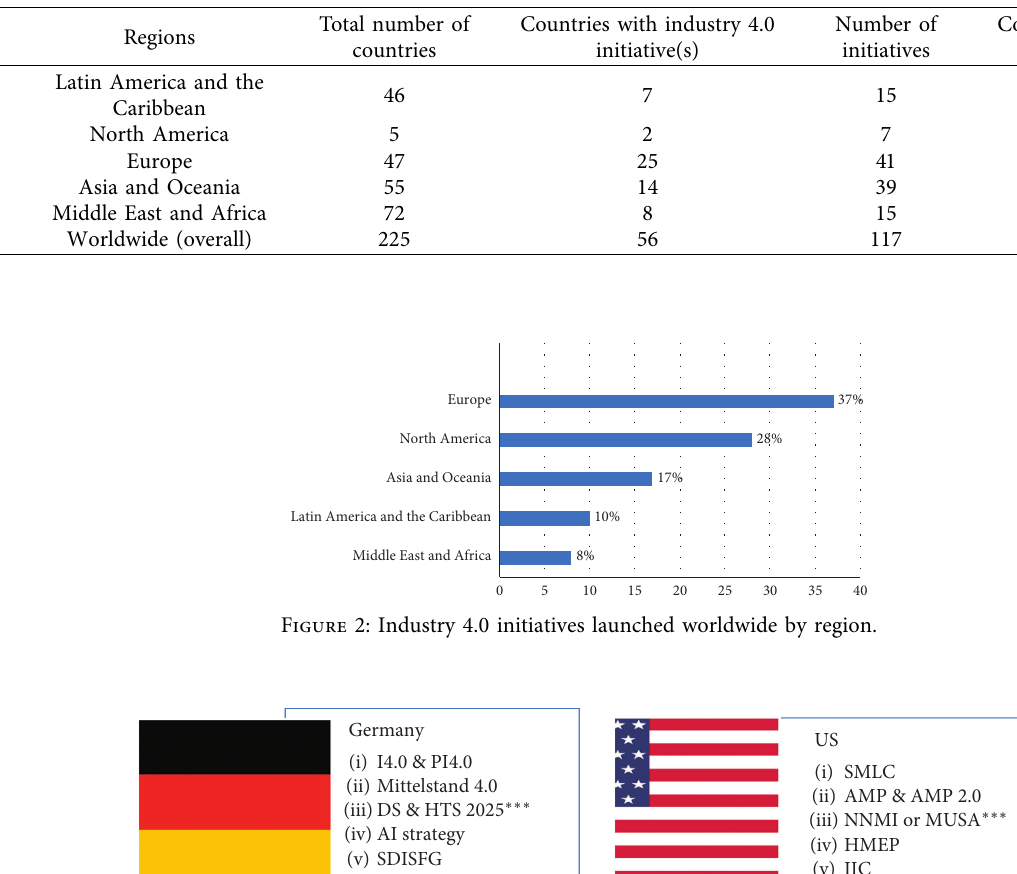
Table 7: Industry 4.0 initiatives launched across the world.